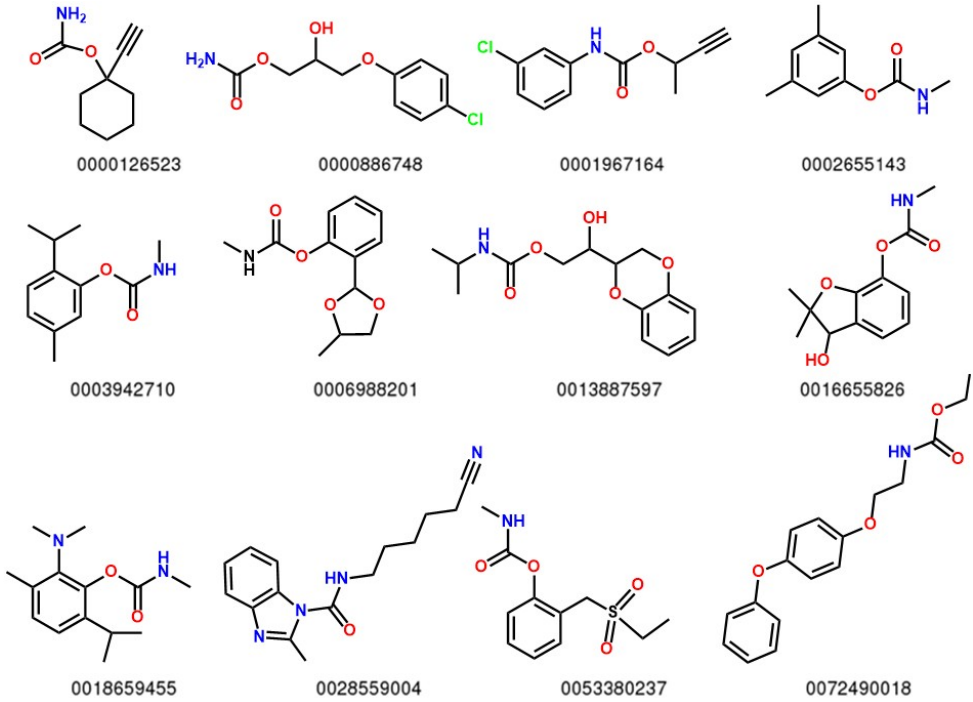
Figure 1. Twelve molecules randomly selected to represent the entire set of carbamates; the numbers are the ids from ChemID (Full set is reported in supplementary material).